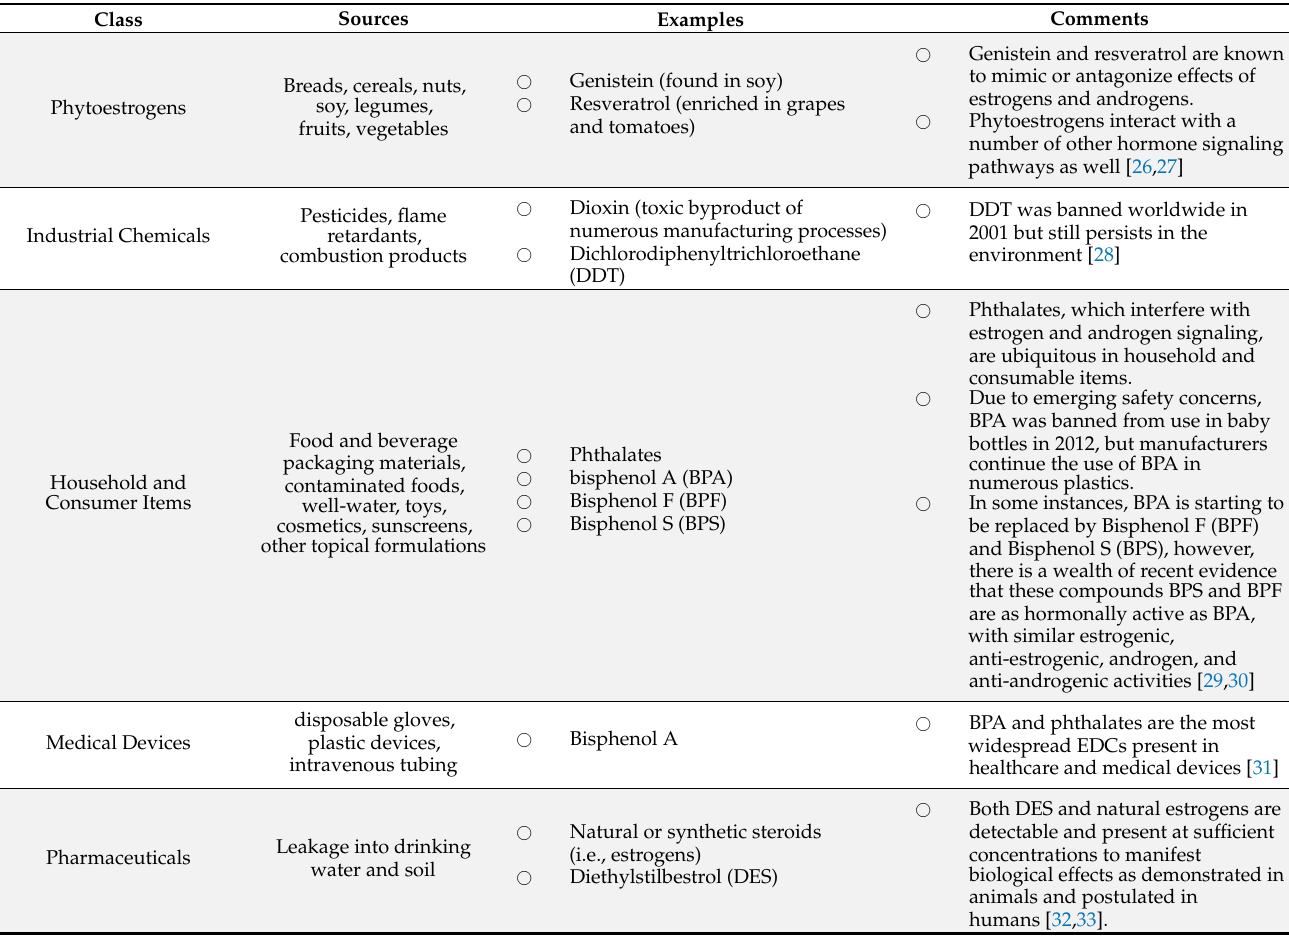
Table 1. Classes of common